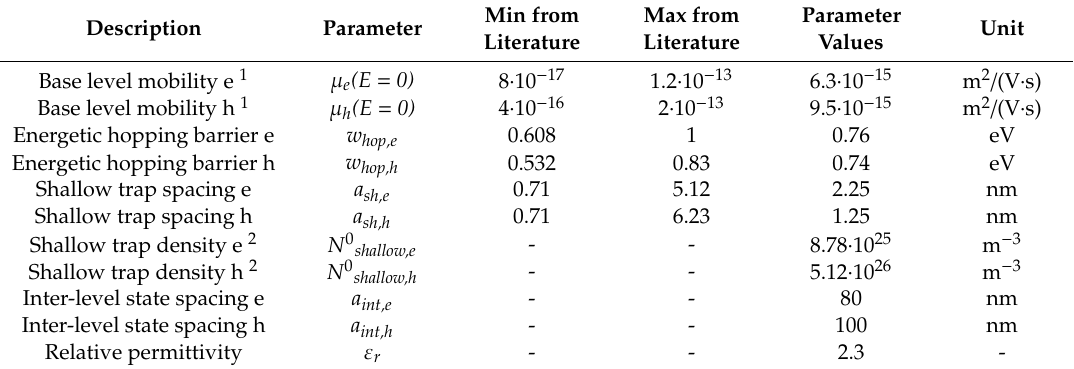
Table 1. Ranges of conduction parameters from [3–11] and their values used in the